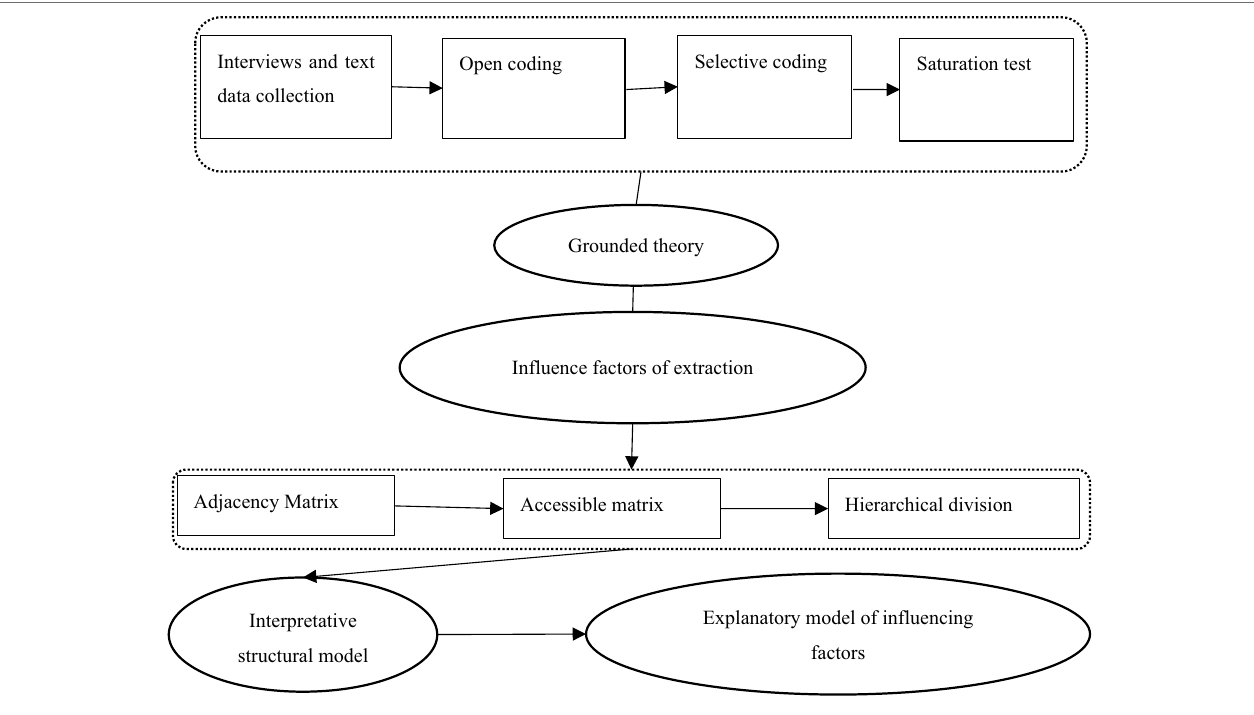
FIGURE 1 | Research flow